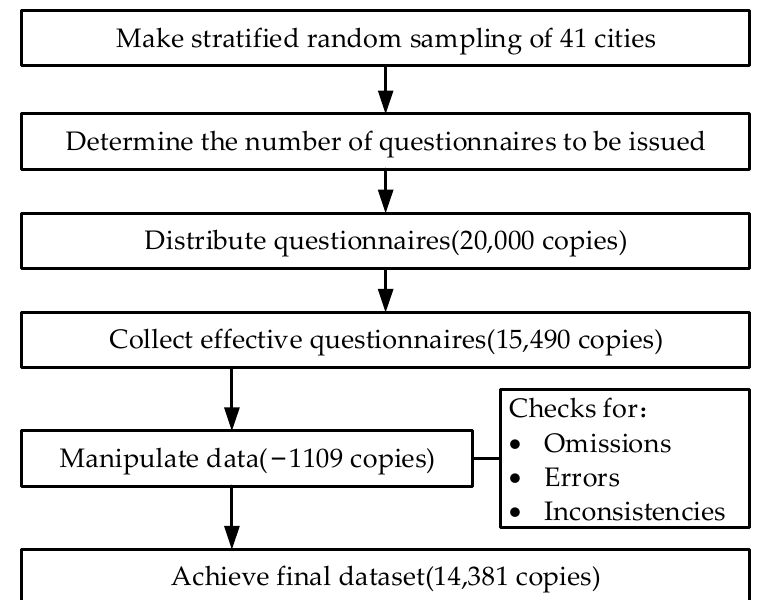
Figure 1. Data collection flowchart.